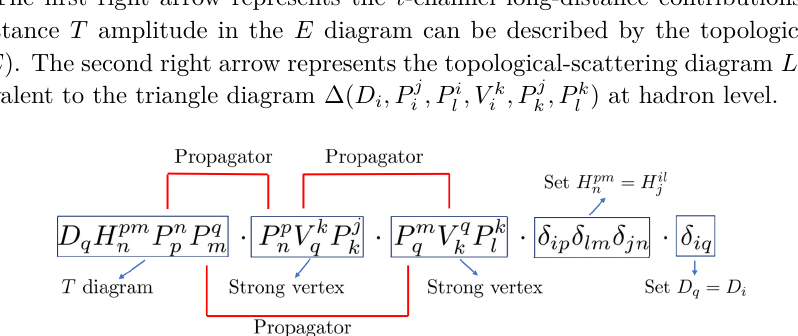
Figure 4 . The triangle diagram constructed by the topological-scattering diagram in T ⇒ E